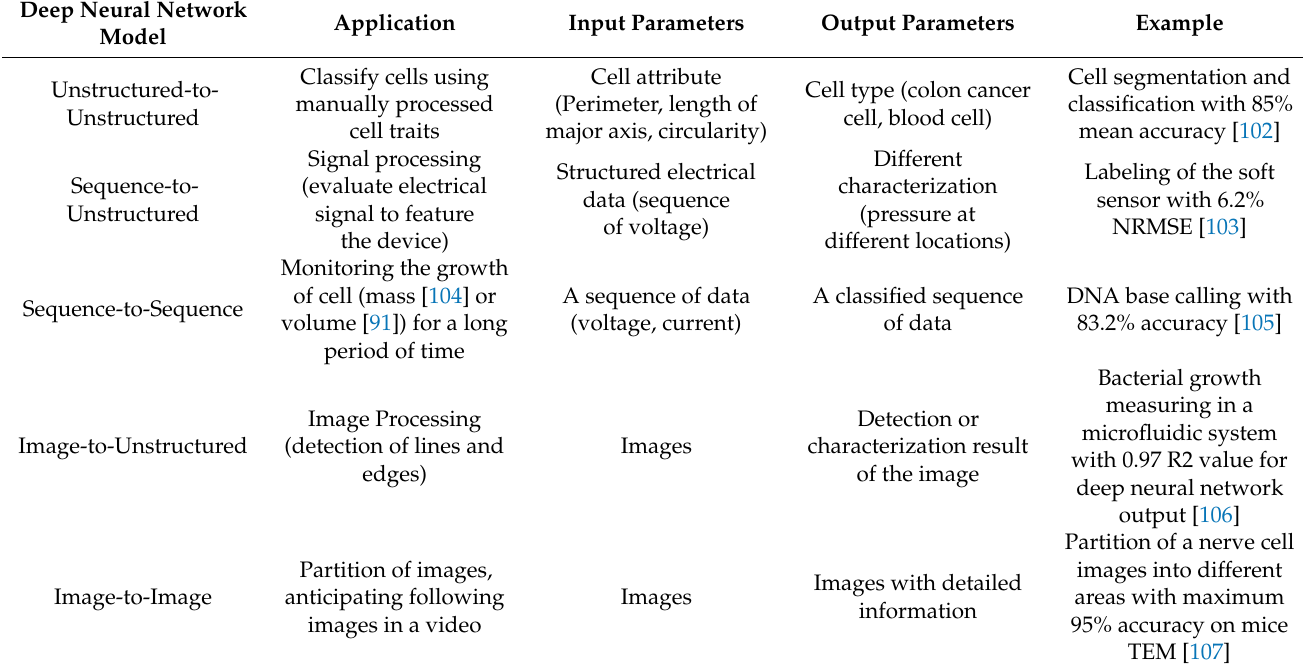
Table 1. Representation of the architecture model in microfluidic